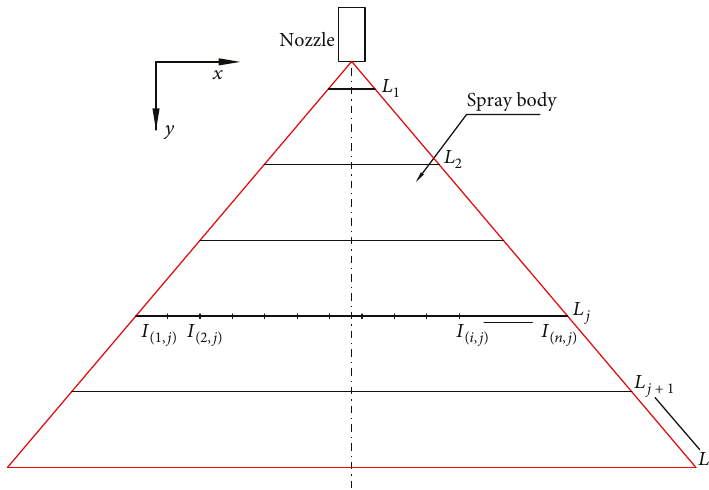
Figure 9: The diagram of local light intensity corresponding to the point in the spray body.